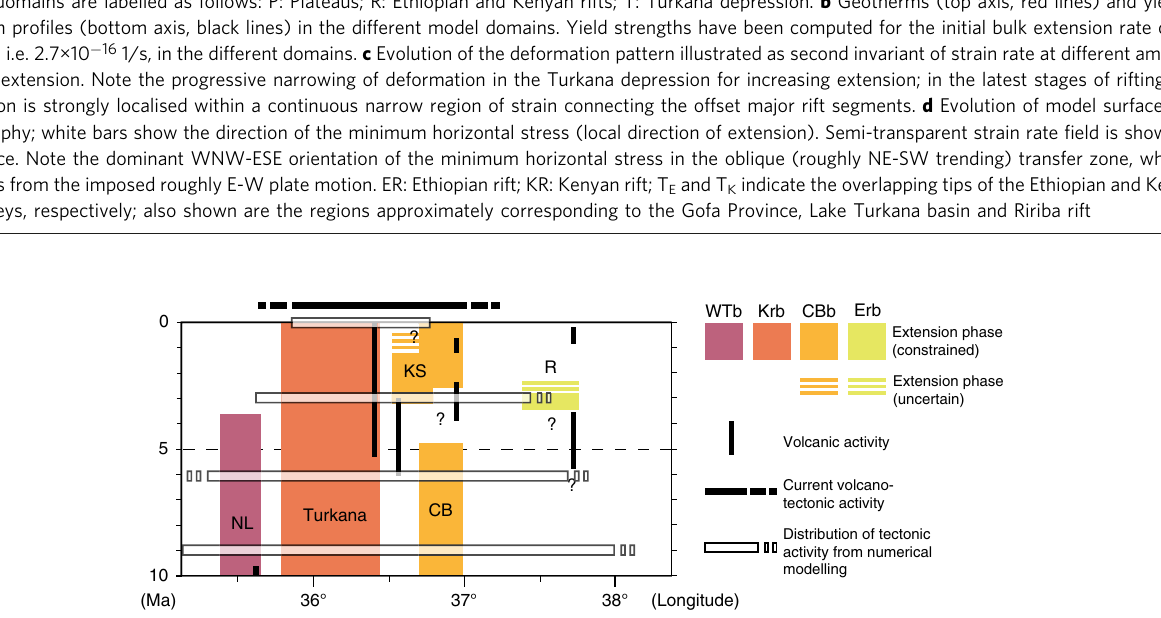
Fig. 7 Spatio-temporal evolution of recent deformation in the Turkana depression and comparison with model predictions. Chronograms illustrating the spatial and temporal relationship of late Miocene-recent extension and volcanic activity. Reported are the current distribution of volcano-tectonic distribution from available geological and geophysical data, and the spatial distribution of tectonic activity at different time intervals as predicted from numerical modelling. Colours indicate the different deformation domains (WTb: West Turkana basins; Krb: Kenyan rift basins; CBb: Chew Bahir basins; Erb: Ethiopian rift basins). CB: Chew Bahir; KS: Kino Sogo; NL: North Lokichar; R: